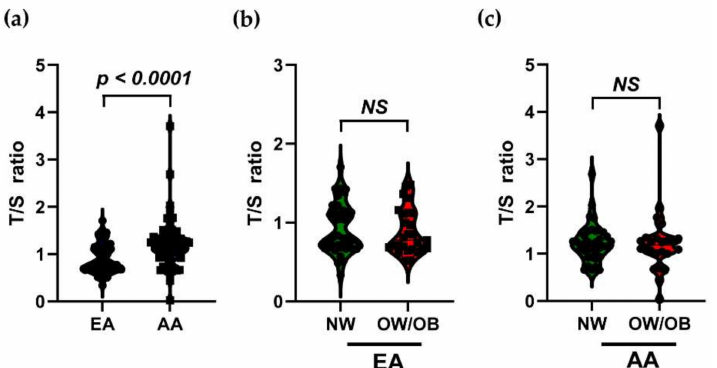
Figure 1. The violin plot with data points shows the distribution of the T/S ratio in EA and AA children. ( a ) The mean T/S ratio is compared between EA and EA children. The T/S ratio of NW and OW/OB children is compared in EA ( b ) and AA children ( c ). Values are expressed as mean ± SEM. European American (EA); African American (AA); normal weight (NW); overweight/obese (OW/OB); telomere length/ single copy gene (T/S ratio); Not significant